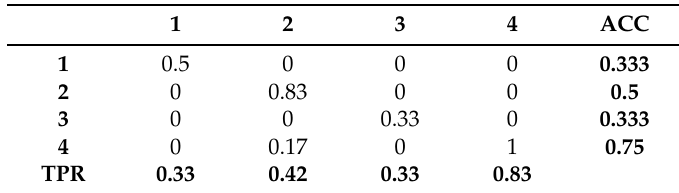
method with tree decomposition algorithm. Column headers represent predicted values, row headers represent actual values.